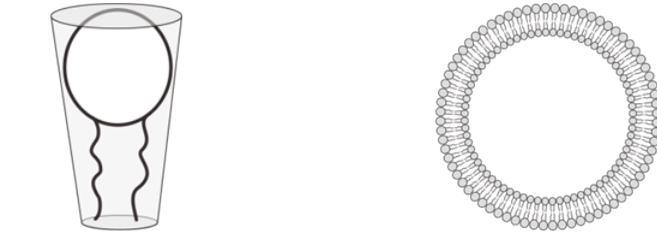
Figure 2 : Self-assembled prediction of phospholipid